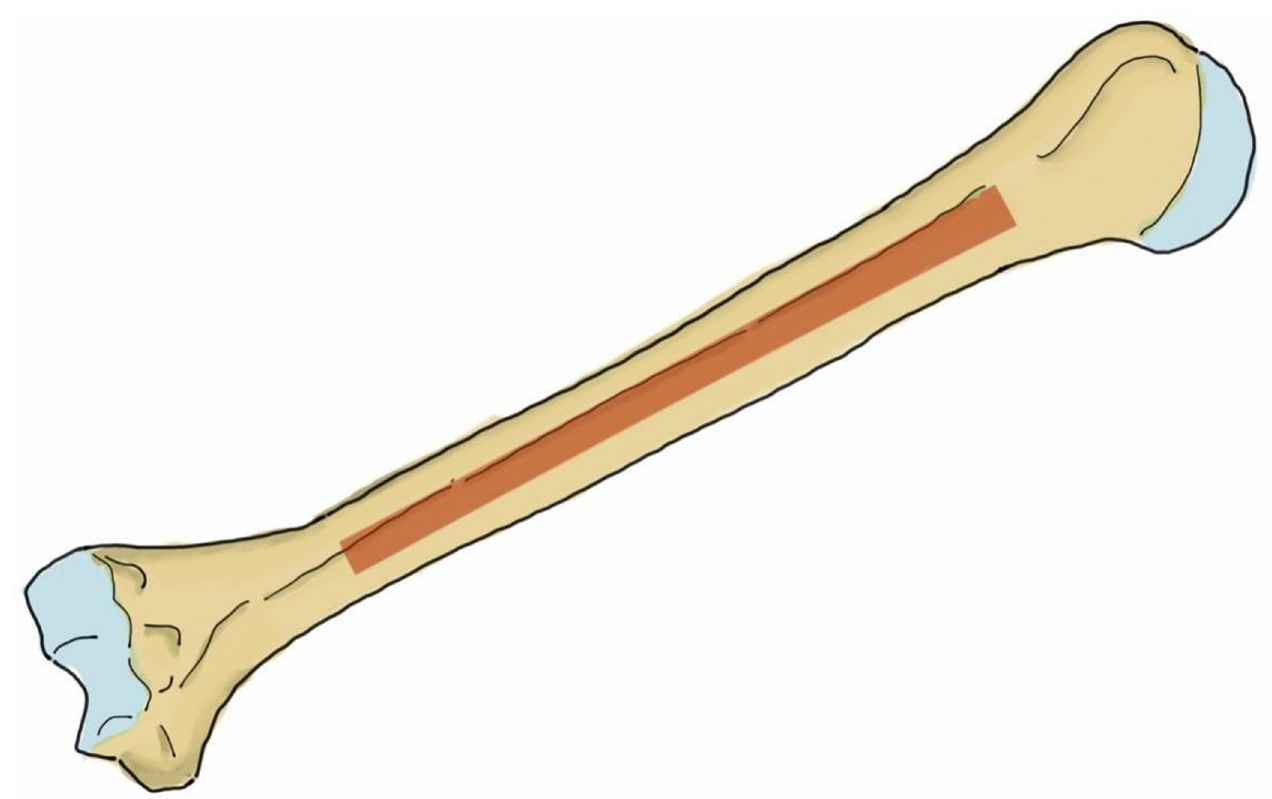
Fig 2. The mid-anterior aspect of the humerus (brown shaded area) shows the area in which the plate can be applied.